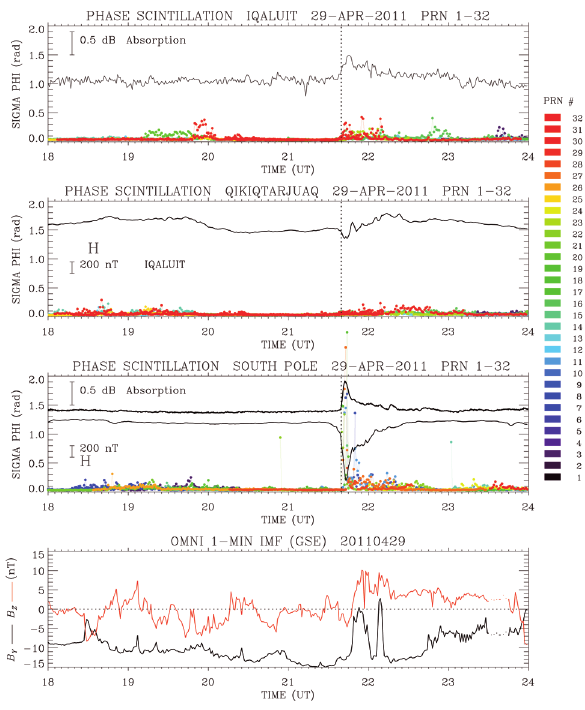
Figure 3. In colors (top three panels), the phase scintillation index v U observed at elevations above 30° on April 29, 2011. The riome- ter absorption and the H components of the ground magnetic field measured at IQA and SP are superposed in the scintillation panels. The IMF B and B are shown in the bottom panel. Y Z